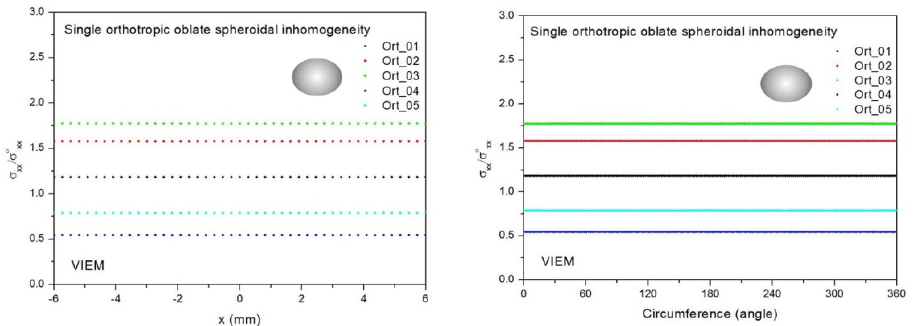
Figure 20. VIEM results for the normalized tensile stress component ( σ xx / σ oxx ) along ( left ) the x–axis inside and ( right ) the circumferential direction of the orthotropic oblate spheroidal inclusions (Ort_01, Ort_02, Ort_03, Ort_04 and Ort_05) with b/a = c/a = 0.5 (a = 6 mm) under uniform remote tensile loading.